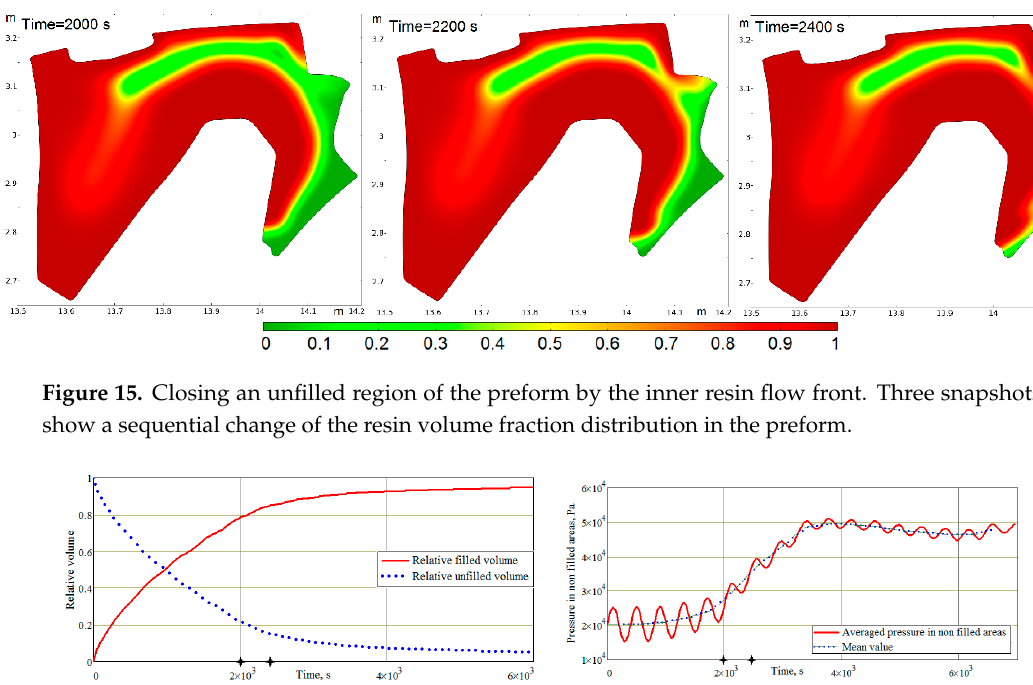
( b ) Figure 17. Change of the harmonic component ( a ) and amplitude ( b ) of the averaged pressure inside the unfilled regions during vacuum infusion. Figure 18. Time history of the vent’s air flow rate during vacuum infusion. The considered results demonstrate that proposed computations can be used to exclude the suspicious modeling scenarios in which the formation of dry places is possible. However, a much more reliable conclusion about the process quality at its accepted conditions can be made using the algorithm processed the simulation results. The most important elements and results of this algorithm working in the MATLAB environment are described below. This algorithm includes the following sequential steps, which are illustrated for three different situations: (a) no dry spot formation, (b) dry spot is formed by the inner flow front and (c) dry spot is formed by the outer resin flow front (see Figure 19).